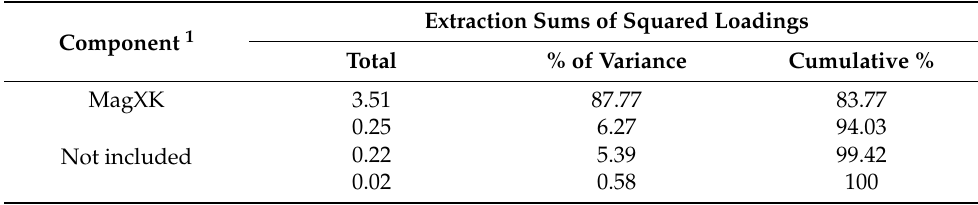
Figure 6. Magnetic proxy (MagXK) of biogenic reefs in core XK-1. ( a ) MagXK (red bold line) with magnetic parameters (dashed thin lines), versus eccentricity on a 405 kyr band (dashed bold line) [55]. ( b ) The evolution spectrum of the MagXK. ( c ) The squared wavelet coherence [56] between MagXK and eccentricity. The thick black contour designates the 5% significance level against red noise, and the cone of influence (COI) where edge effects might distort the picture is shown as a lighter shade. Arrows: in-phase pointing right, anti-phase pointing left. Table 1. Results of a principal component analysis of magnetic